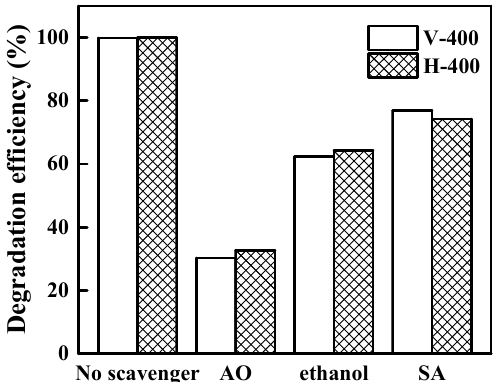
Figure 8. Degradation (%) of MB in without quencher and in presence of scavengers.